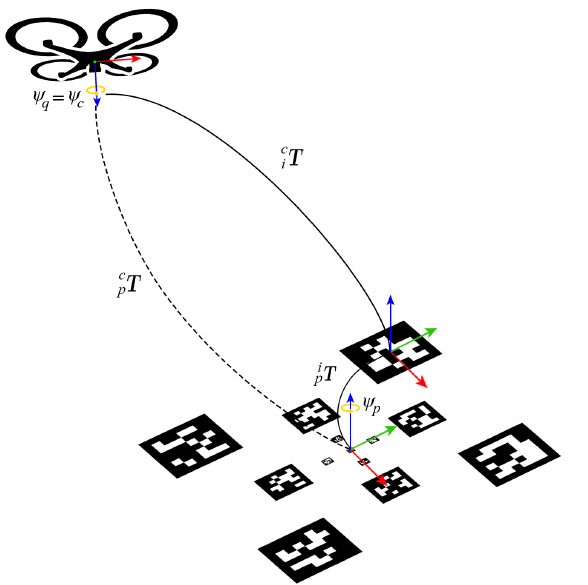
Figure 3. A representation of the different transformation matrices involved in the relative pose estimation between the UAV and the landing platform’s